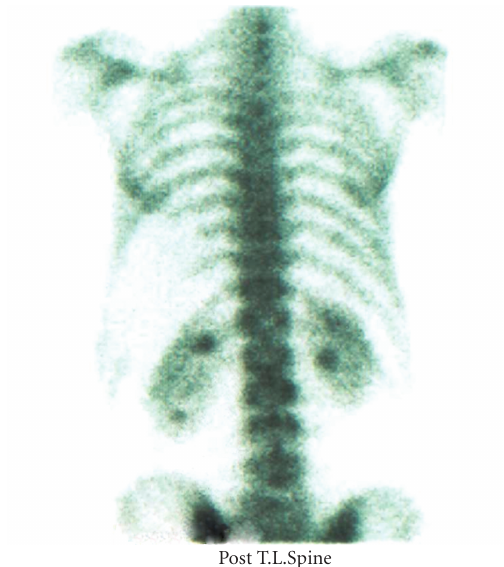
Figure 4: The synchronous bone scan shows no significant abnormality in the spine compared to the MRI scan.